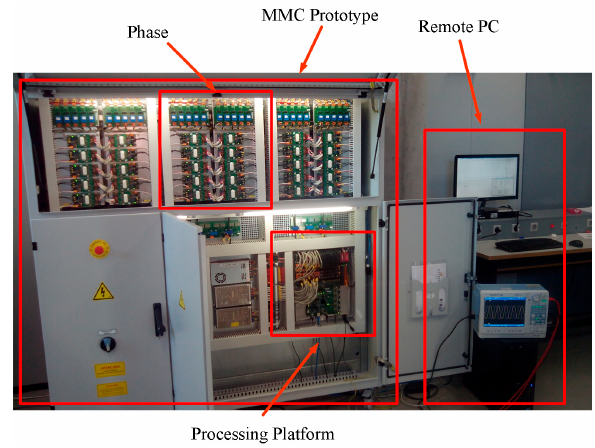
Figure 21. Modular multilevel converter prototype and remote PC.